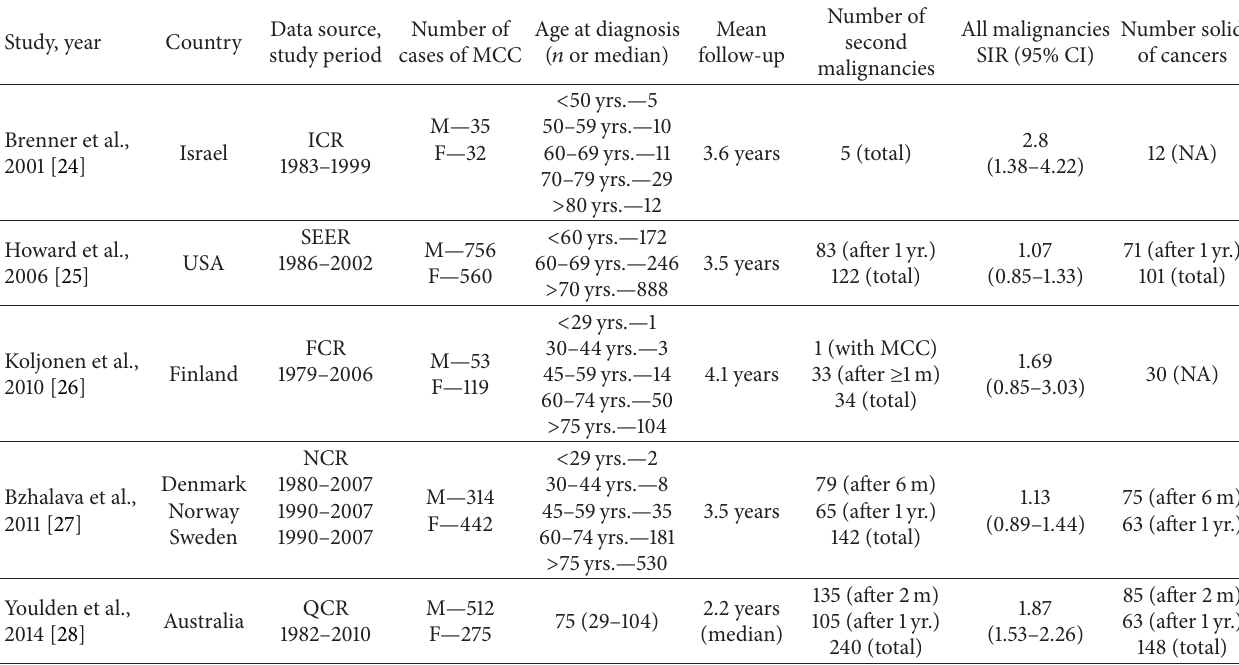
Table 1: Characteristics of studies included in the meta-analysis.